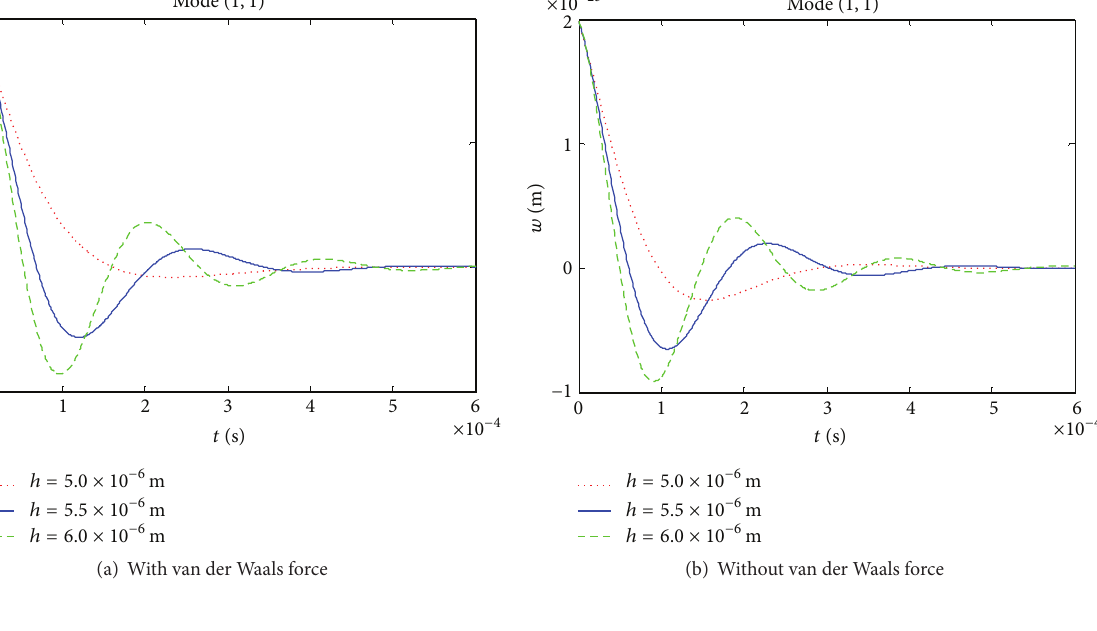
rapidly and then more slowly with time compared to those in the case when the van der Waals force is considered. As the initial tension stress of the micro film grows, the effects of the van der Waals force on the vibrating amplitudes of the film center first become small and then become large. (5) As the voltage between the micro film and the back plate grows, the vibrating amplitudes of the film center drop more rapidly with time. When the van der Waals force